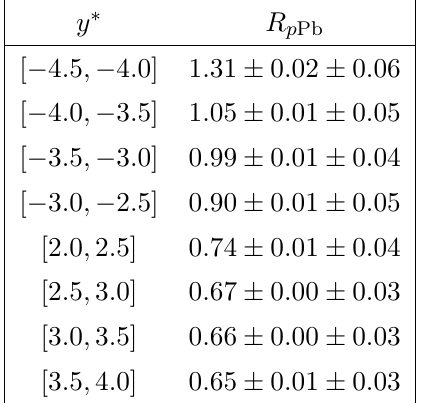
Table 6 . Nuclear modi(cid:12)cation factor R p Pb for prompt D 0 meson production in di(cid:11)erent y (cid:3) ranges, integrated up to p T = 10 GeV =c . The (cid:12)rst uncertainty is statistical and the second systematic. signal yield and tracking are considered fully correlated, while the PID uncertainty is con- sidered 90% correlated since it is a mixture of statistical uncertainty (uncorrelated) and the uncertainties due to the binning scheme and yield determination (correlated). All other uncertainties are uncorrelated. The measured R values are shown in (cid:12)gure 8, as a func- FB tion of p integrated over the range 2 : 5 < j y (cid:3) j < 4 : 0, and as a function of y (cid:3) integrated T up to p = 10 GeV =c . The R values in di(cid:11)erent kinematic bins are also summarised in T FB table 7. Good agreement is found between measurements and theoretical predictions using EPS09LO and nCTEQ15 nPDFs. The calculation using EPS09NLO nPDF also agrees with the data within the theoretical uncertainties.